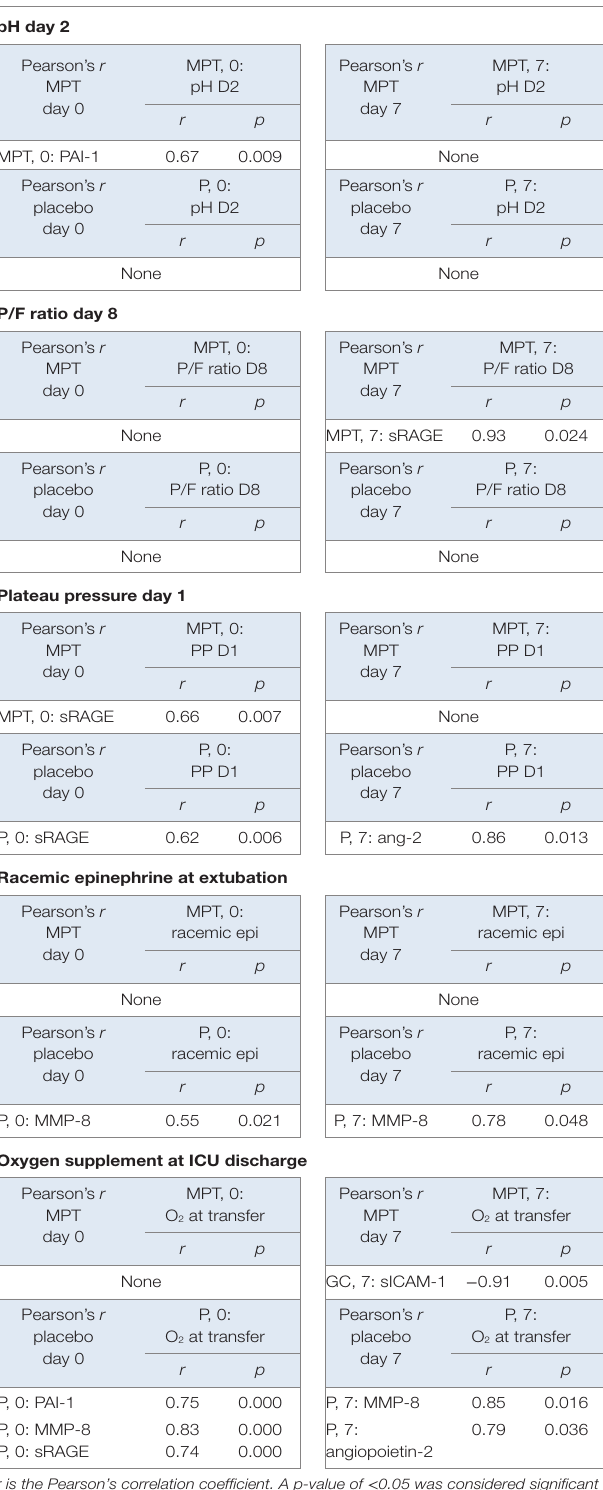
parameters n = 18 and day 7: biomarkers n = 7 and clinical parameters n = 7).